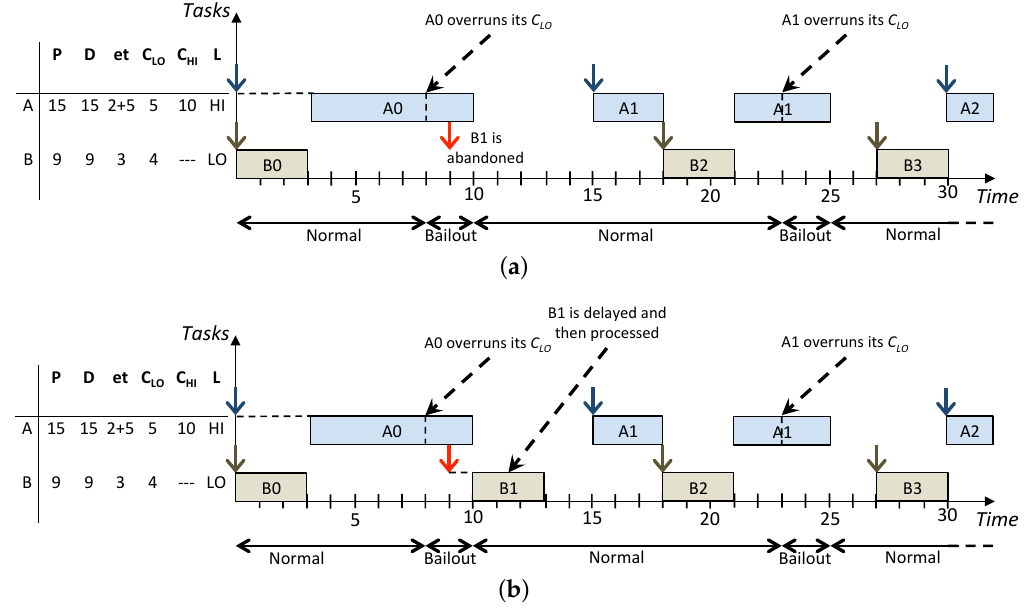
Figure 6. (Proof of Theorem 5, Part 2) LBPS always schedules more LO jobs than BPS: ( a ) BPS abandons job B 1 ; and ( b ) LBPS schedules all LO